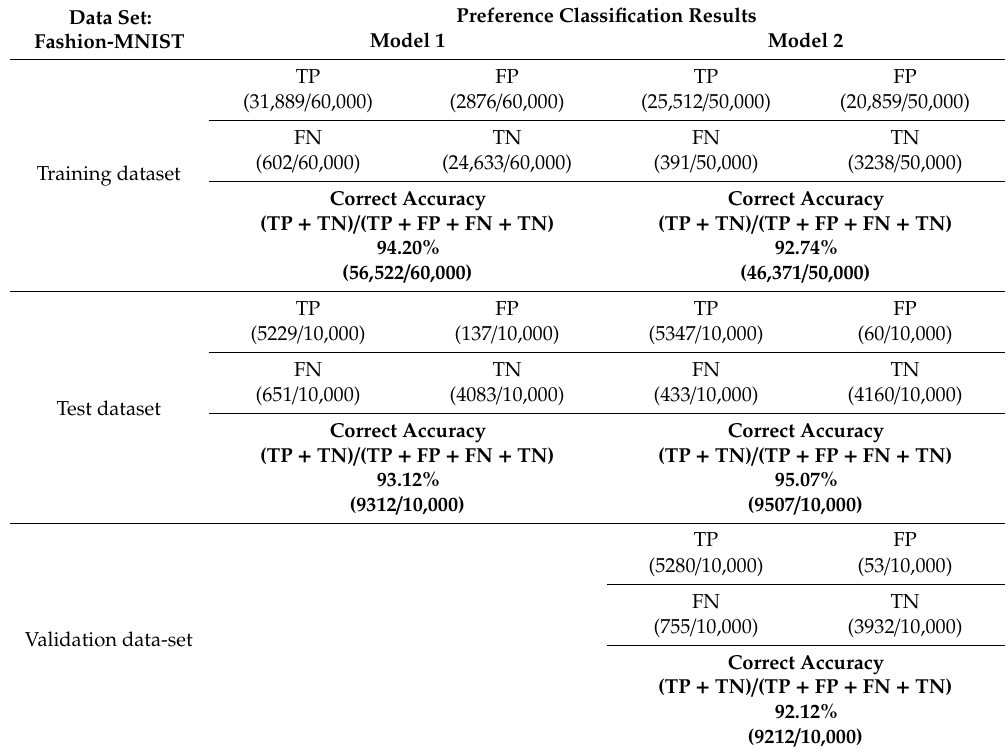
Table 2. Preference classification results with the Fashion-MNIST dataset.